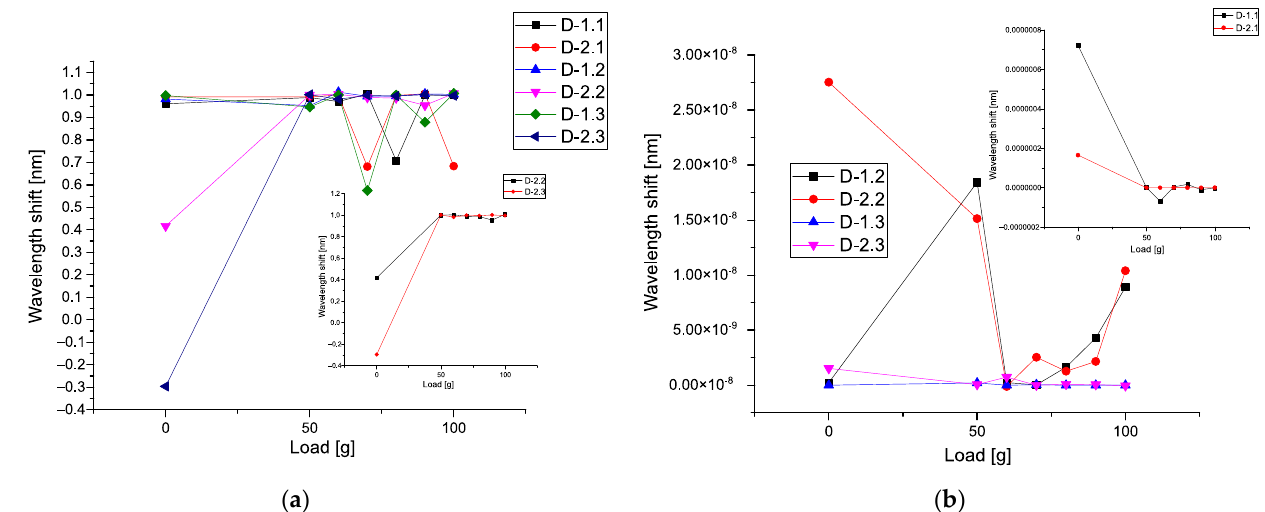
Figure 9. ( a ) Calibration curves calculated for mean values of the third-order correlators; ( b ) calibration curves calculated for mean values of the fourth-order correlators.